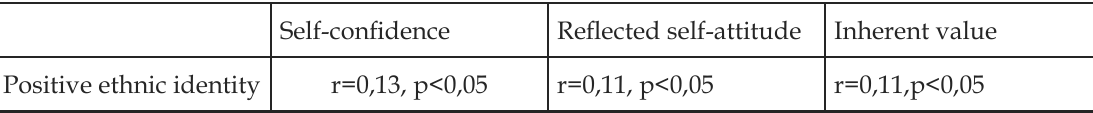
Tab. 1. The correlation of positive ethnic identity with the components of